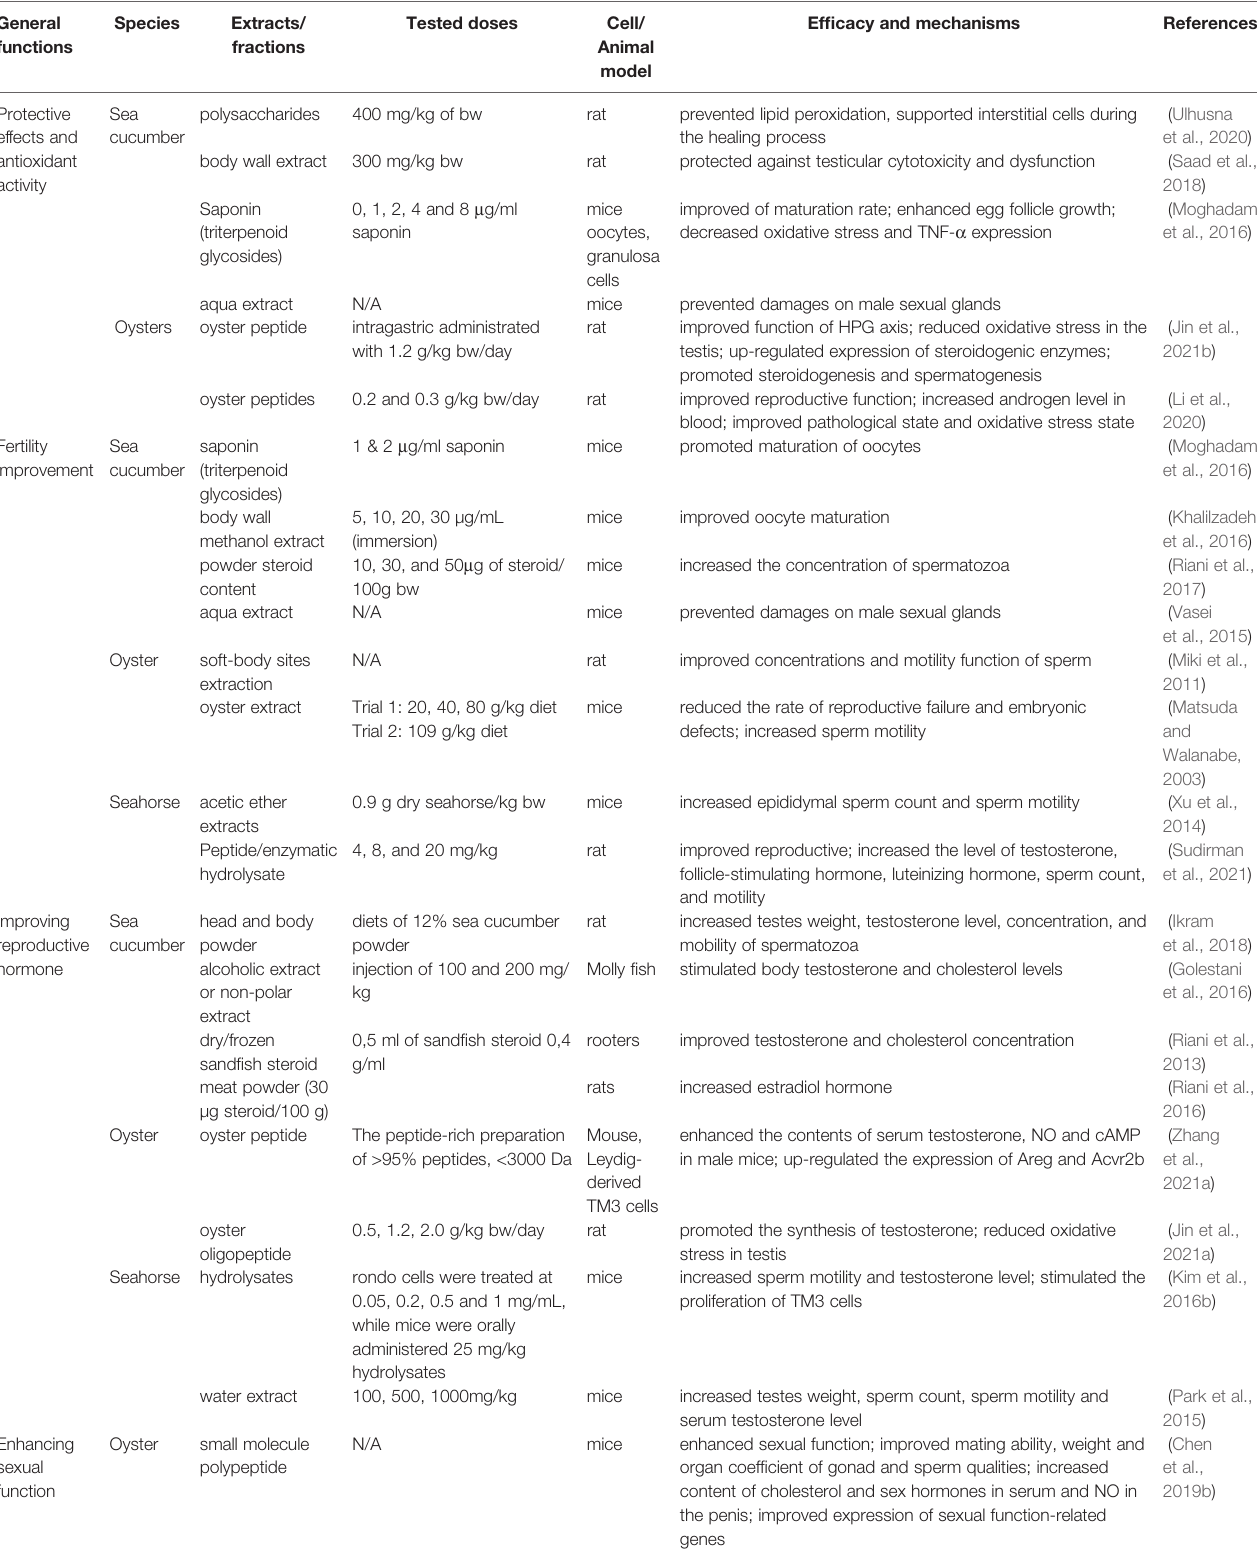
TABLE 1 | Summary of marine animals and their potential bioactive compounds reported to exhibit bene fi t to human sexual function and reproduction health. General